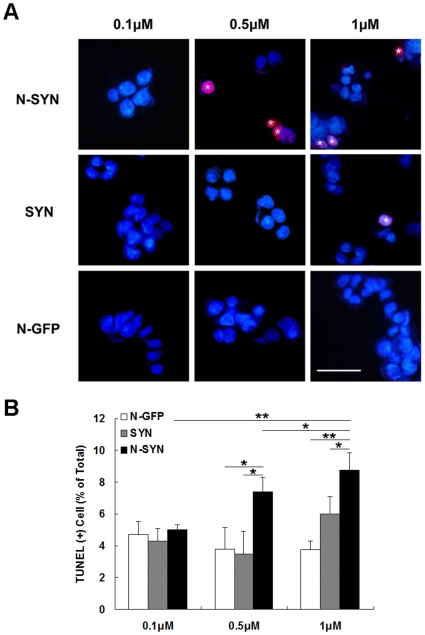
N-SYN induces apoptosis of SHSY-5Y cells.Apoptosis was determined by TUNEL staining after incubating SHSY-5Y cells with the indicated concentration of N-SYN, SYN or N-GFP for 5 h. Representative images of cells in each treatment group are shown in (A). Typical apoptotic cells (marked by asterisks) displayed chromatin condensation accompanied by shrinking of the soma (Hoechst, blue; TUNEL, red). (B) Quantification of the proportion of apoptotic cells in each treatment group. Data are expressed as percent of TUNEL-positive vs. Hoechst-positive cells and presented as mean ± SEM from at least three independent experiments. *, p<0.05; **, p<0.01. Scale bar, 40 µm.